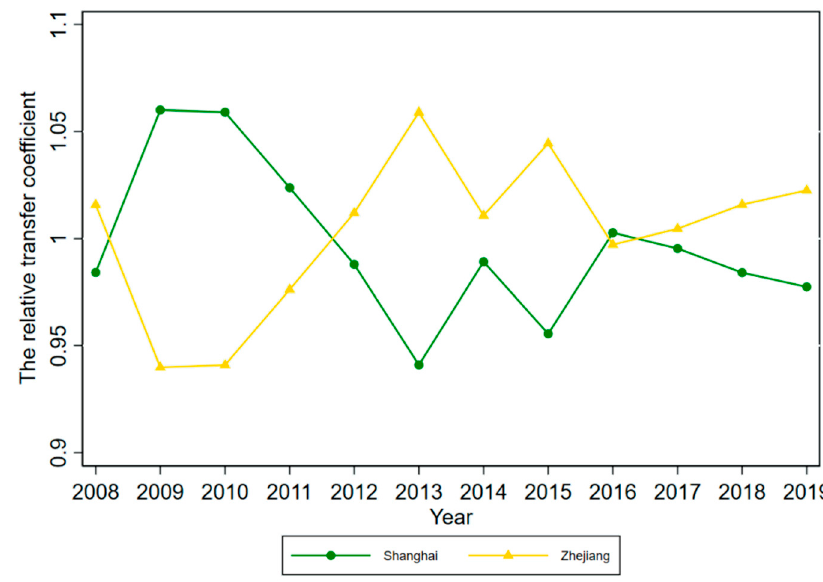
Figure 5. Relative transfer paths of HQDM levels in Club 2 member provinces.